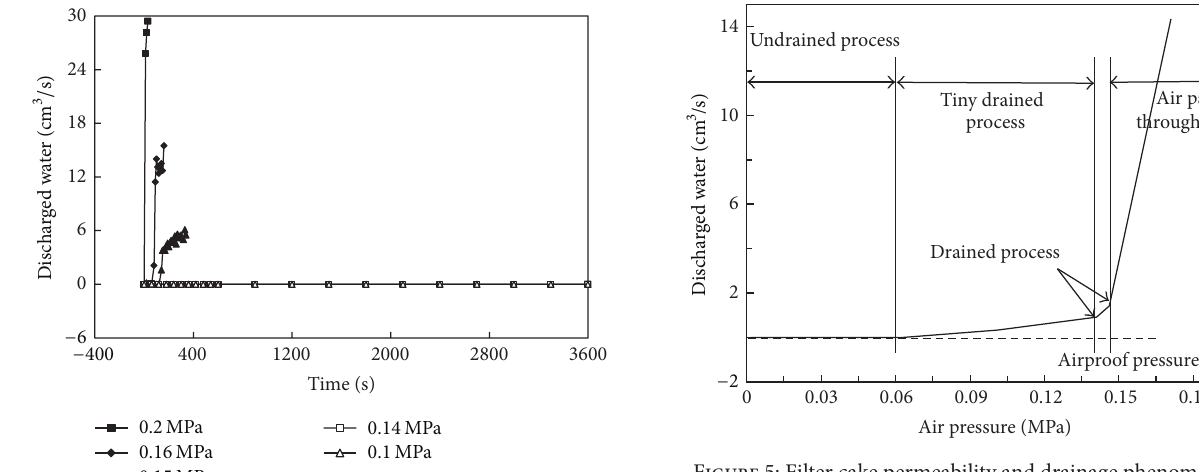
Figure 5: Filter cake permeability and drainage